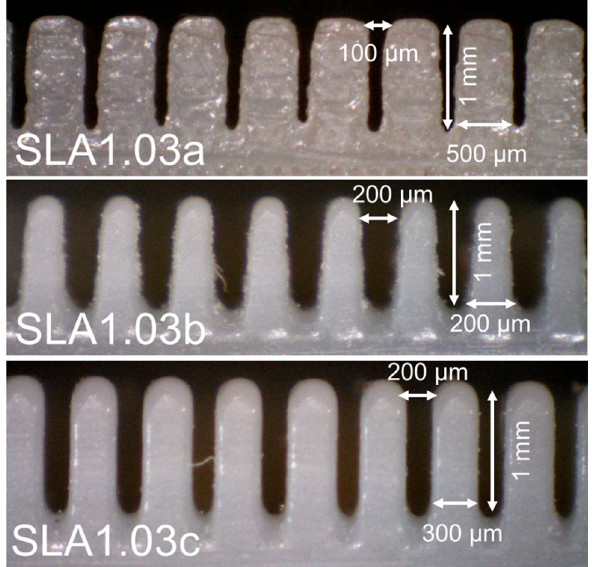
Figure 7. SLA (stereolithography) micro-grooves with various thicknesses and spacing fabricated to measure the capillary height. The micro-groove width range is between 100 to 500 µm. The micro-groove depth is 1 mm and their thickness ranges between 200 to 500 µm. Table 1 lists the sample details.